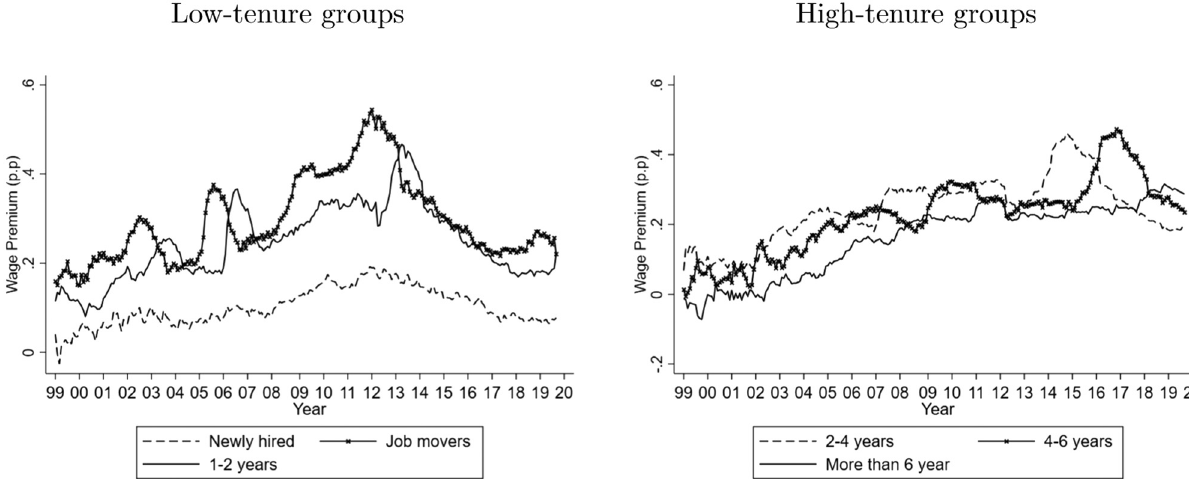
Figure A17: Wage premium by tenure group. Note: The wage premium is computed as ( ) ∕ w w ¯ ¯ − 1 N t M t , , , where w ¯ j t , is the monthly average wage for natives = j N and immigrants = j M at month t . Source: